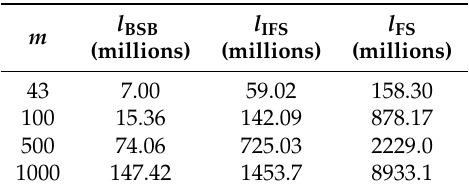
Table 4. Comparison of the number of parameters among behavioral similarity-based (BSB), ignored feature selection (IFS), and forward search (FS) methods. m